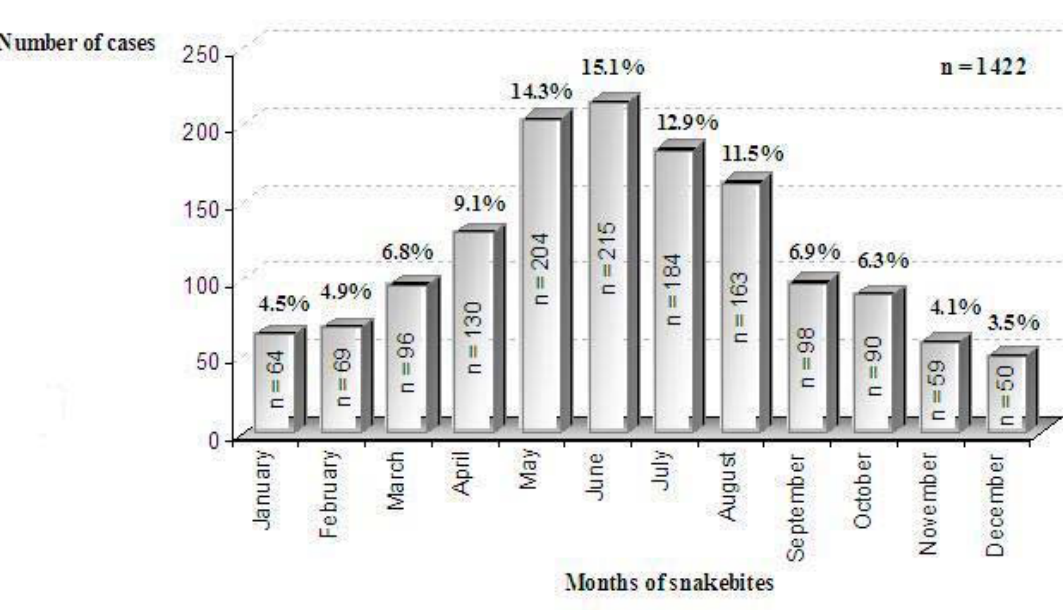
Figure 5. Distribution of snakebites according to the months of the year.